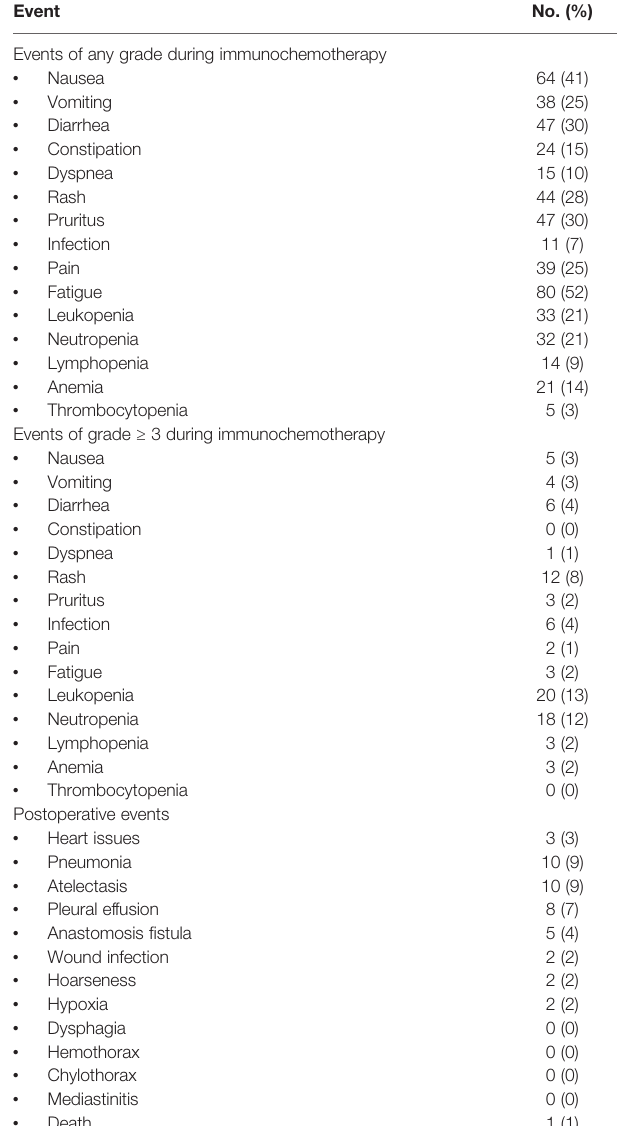
TABLE 2 | Adverse events during immunochemotherapy and after surgery.